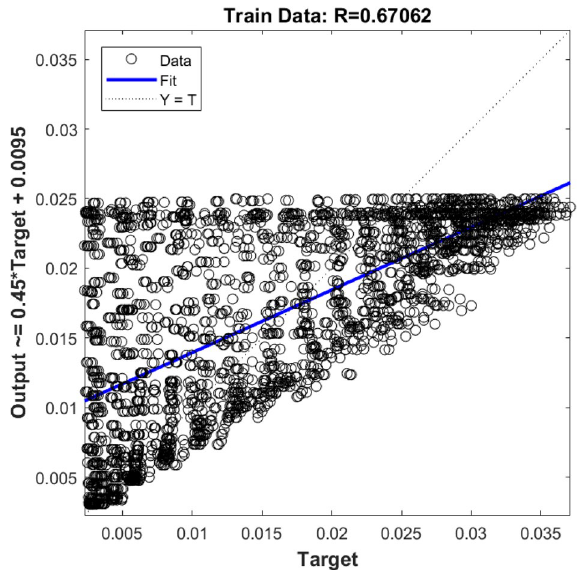
Figure 6. Training validation of liquid velocity for the ANFIS model with one input. The ANFIS model’s output is the liquid velocity distribution, and it is validated against the velocity component (x-direction) in the CFD calculation (target value).